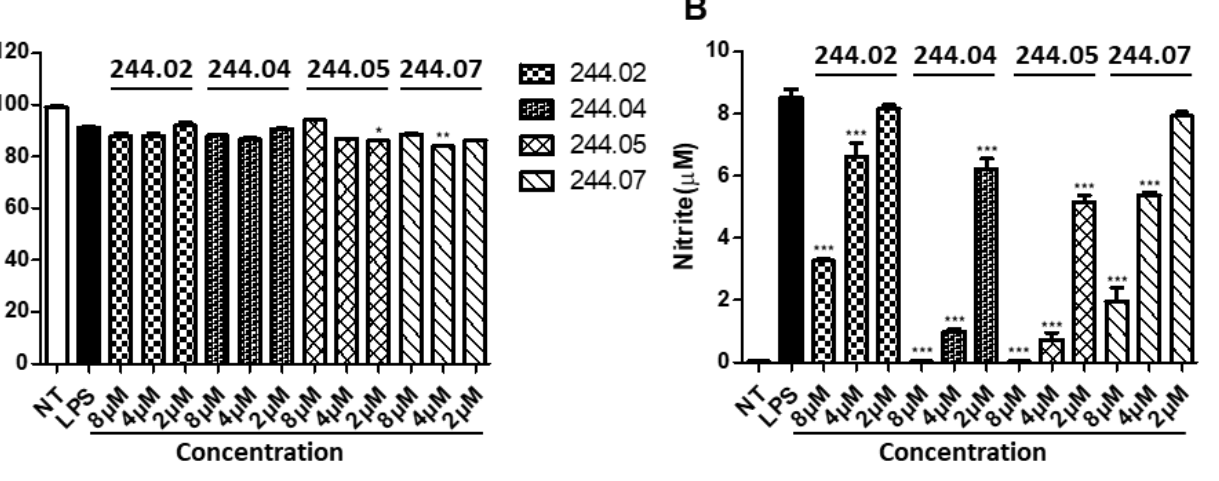
Figure 3. Initial screening of selected WALK244 peptides for immunomodulatory potential in J774A.1 cells. All bar graphs represent the mean ± SEM of three independent experiments (* p < 0.05, ** p < 0.01, and *** p < 0.001, significantly different from the control group treated with LPS alone). NT, non-treated; LPS, lipopolysaccharides. ( A ) Cytotoxicity was assessed using the MTT assay. The cells were treated with lipopolysaccharides (LPS, 100 ng/mL) or peptides (8–2 µ M, two-fold serial dilutions) for 16 h, followed by estimating the cell viability as the percentage of surviving cells com- pared to that of the control cells. ( B ) Anti-inflammatory potential deduced by NO assay. Inhibitory effects of pretreated individual peptides on NO release in the cells stimulated by LPS (100 ng/mL) for 16 h were evaluated by measuring the nitrite concentrations in the culture supernatants.